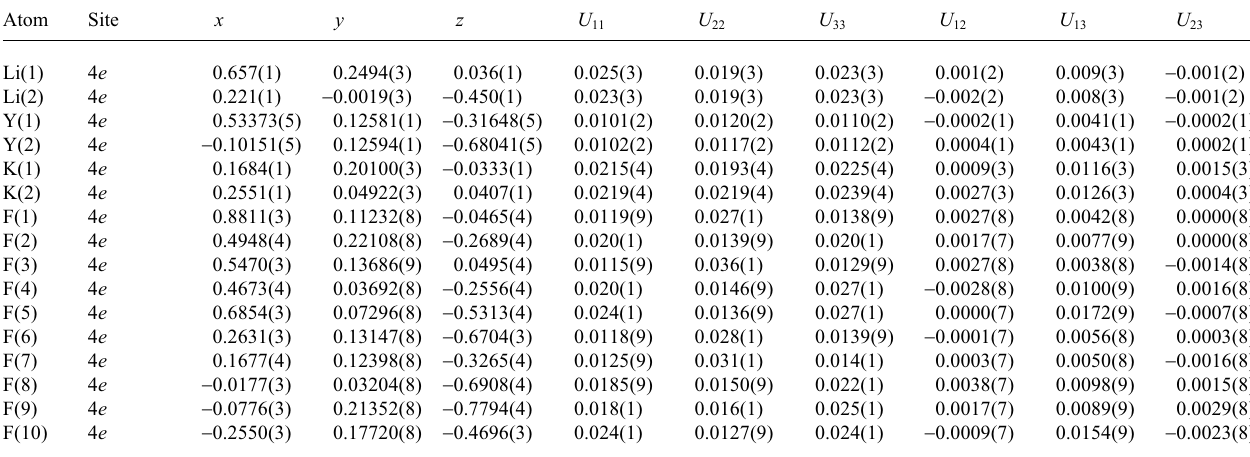
Table 2. Atomic coordinates and displacement parameters (in Å 2 )